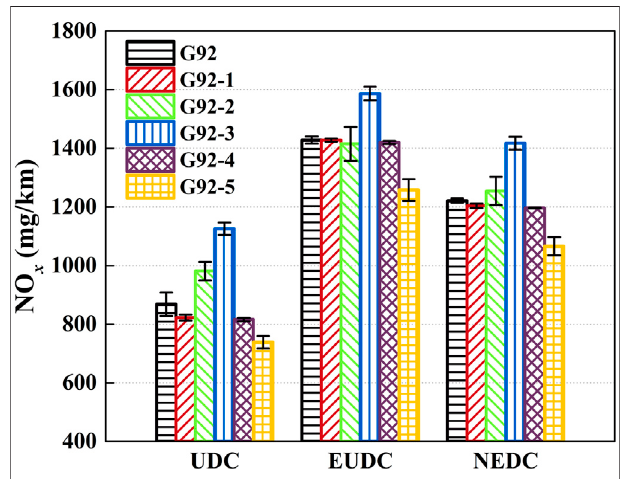
FIGURE 4 | The NO x emissions of the vehicle fueled with different test fuels.